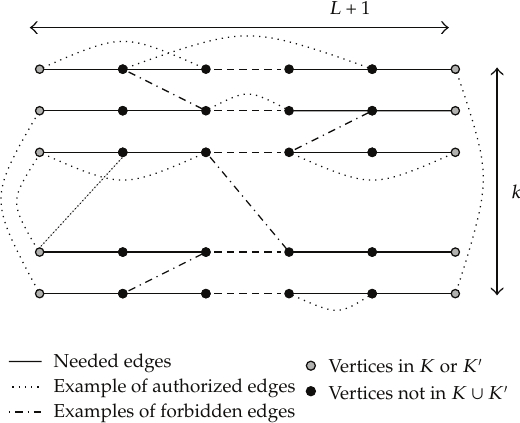
Figure 2: An example of a prism of size k and length L